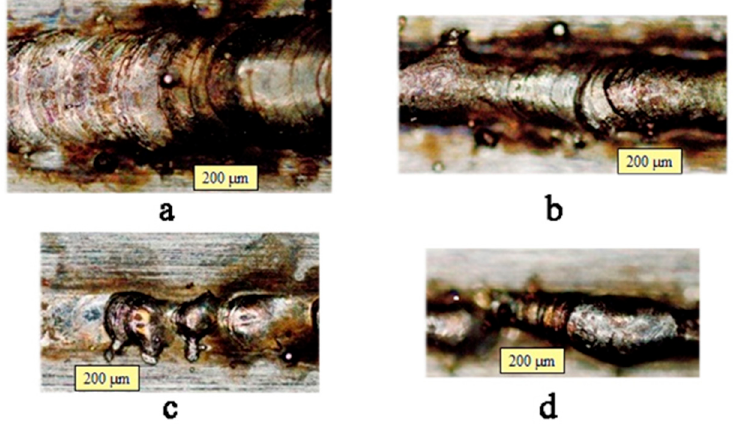
Figure 10. Microphotographs of laser sintering tracks with different modes: ( a )—power 100 W, speed 10 mm/s; ( b )—power 100 W, speed 25 mm/s; ( c )—power 100 W, speed 50 mm/s; ( d )—power 50 W, speed 25 mm/s.